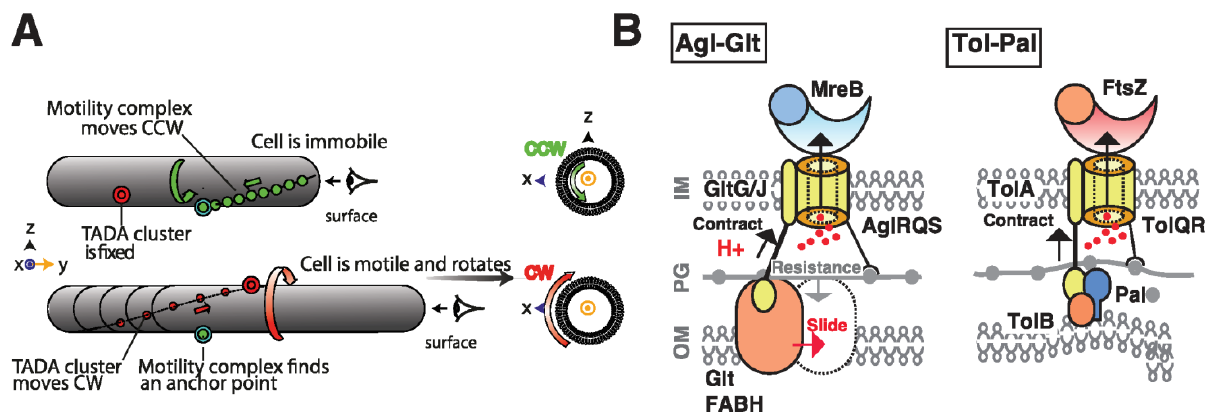
FIGURE 1: (A) The helical movement of intracellular motors drives rotational movement of the cell. Intracellular counter-clockwise (CCW)- motor complexes (green) propel the cell in a screw-like clockwise direction when they become tethered at so-called FAs. (CW, shown by trajectory of a fixed point at the cell surface in red. The CCW or CW directionality is determined by the position of the observer (eye sym- bol). Adapted from Faure et al, 2016 with permission. (B) Core structure and function of the Tol/Exb/Agl class of molecular motors. The Agl- Glt and Tol-Pal systems are shown side-by-side for comparison. The structure of the Agl-Glt machinery is simplified to its core Tol-like com- ponents for clarity. In both cases, the proton flow through a PG-bound TolQR-type channel (yellow) is believed to energize cyclic interac- tions between a flexible IM-anchored periplasmic TonBC domain protein (black-yellow) and TonB-box proteins in the OM (orange). In the case of Agl-Glt, combined with the rigid anchoring to PG (grey arrow), this activity would push the OM protein laterally (red arrow), propel- ling the cell. In Tol-Pal, similar dynamics would provoke OM invagination and participate in cytokinesis. Interestingly, both Tol-Pal and Agl- Glt are physically connected to cytoskeletal proteins, FtsZ and MreB respectively. Adapted from Faure et al, 2016 with